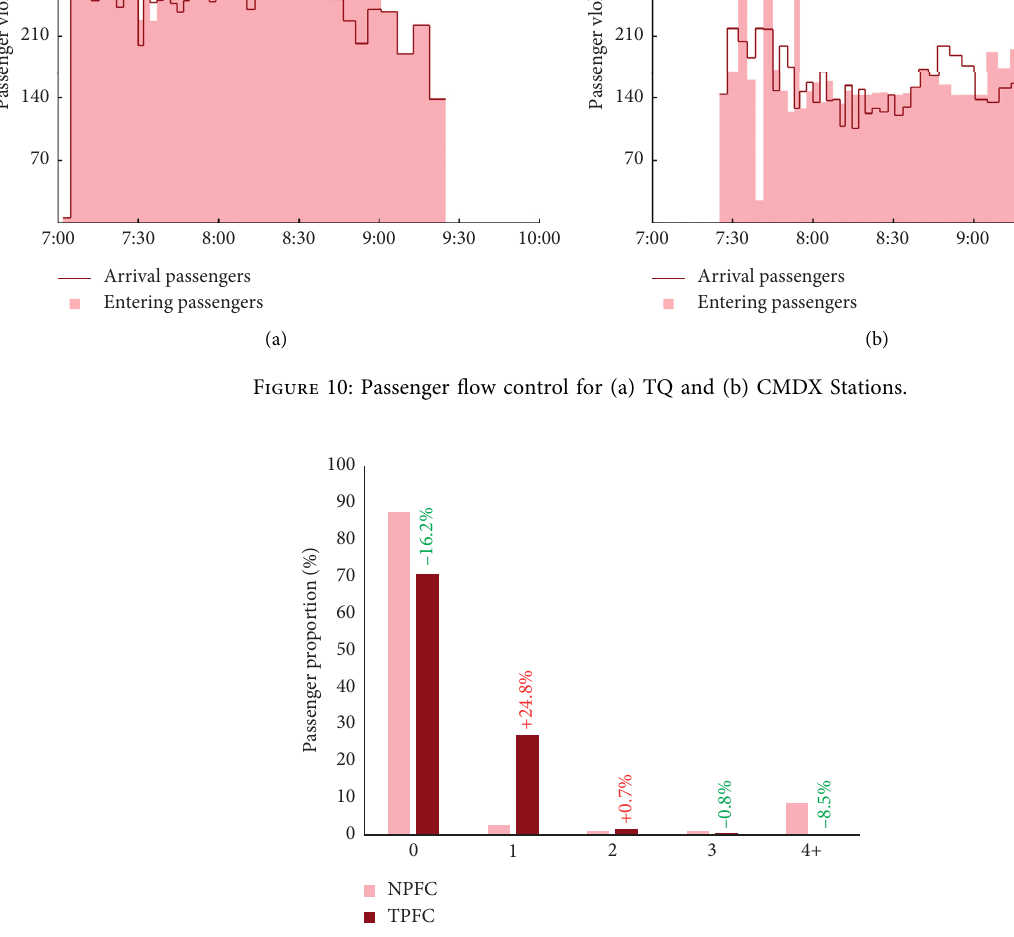
Figure 11: Passenger proportion of different numbers of missed